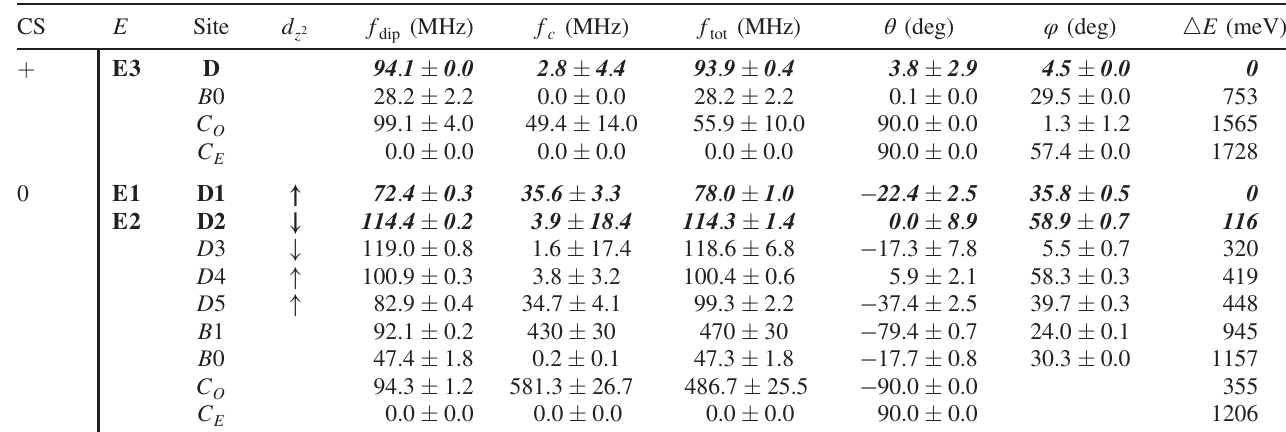
) and contact ( f ) contributions, the vector c dip